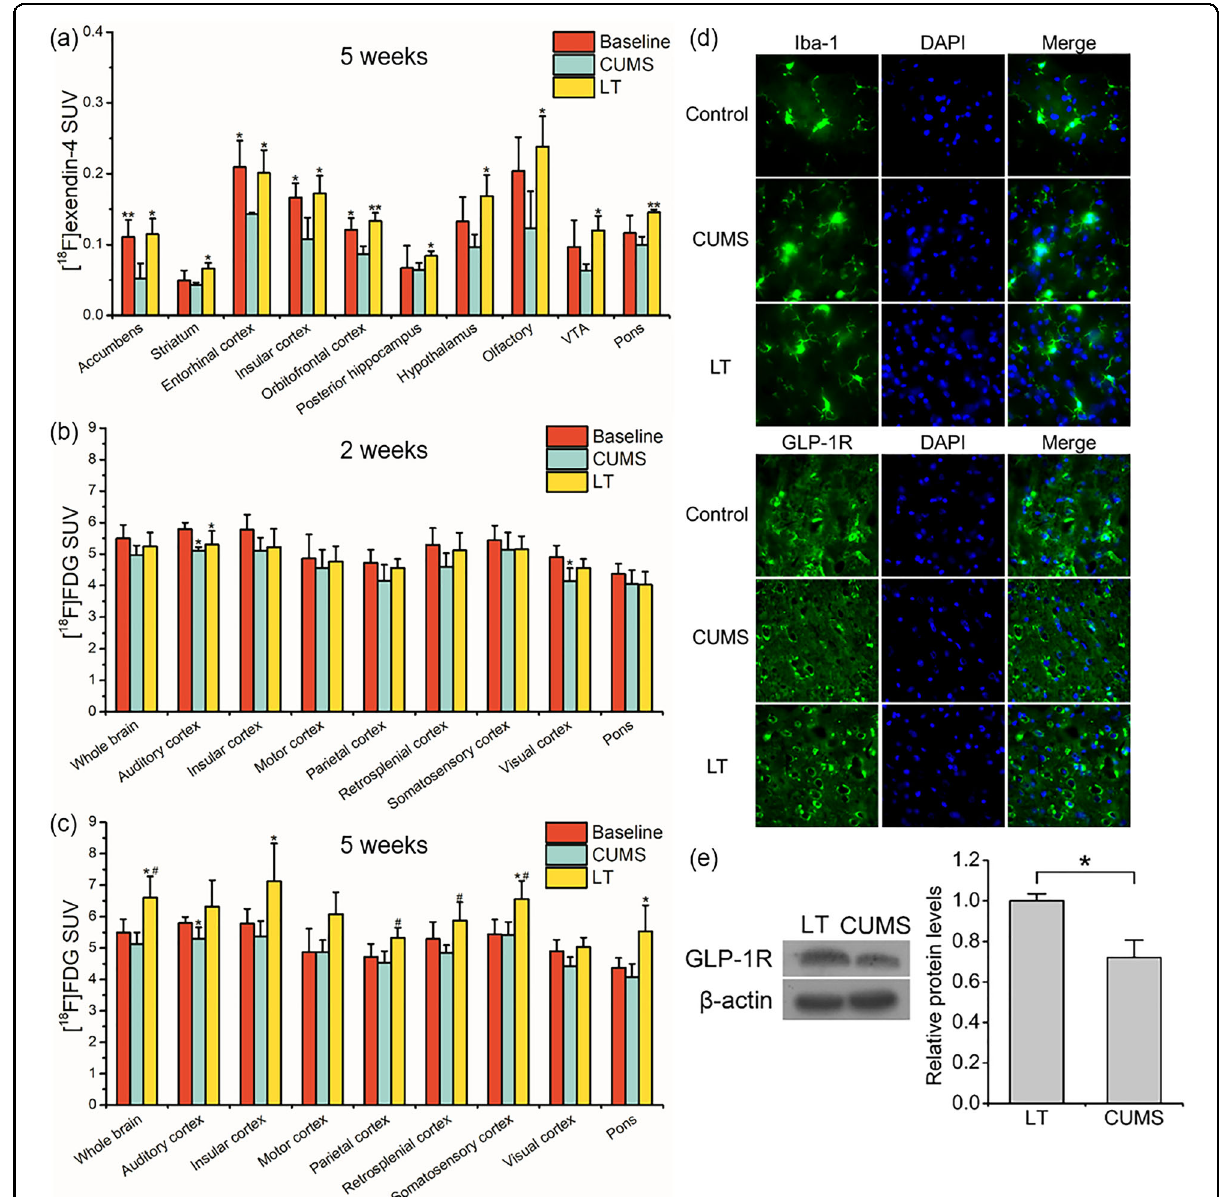
Fig. 4 Multimodal evaluation of light therapy for CUMS-induced depression. a The [ 18 F]exendin-4 quanti fi cation in ten ROIs that showed signi fi cant differences between CUMS and LT groups after 5 weeks of light therapy. * p < 0.05; ** p < 0.01 compared to CUMS group. The [ 18 F]FDG quanti fi cation after 2 weeks ( b ) and 5 weeks ( c ) of light therapy in nine ROIs which showed decreased glucose metabolism caused by CUMS at baseline. * p < 0.05 compared to baseline. # p < 0.05 compared to CUMS group. d Immuno fl uorescence of hippocampal sections from normal rats, untreated CUMS rats, and LT treated CUMS rats. e Western blot analysis of GLP-1R in hippocampus of LT treated CUMS rats and untreated CUMS rats. * p < 0.05. VTA ventral tegmental area. n = 6 (CUMS and LT) and n = 12 (baseline) for PET imaging ( a – c ). n = 3 for western blot and immuno fl uorescence ( d , e